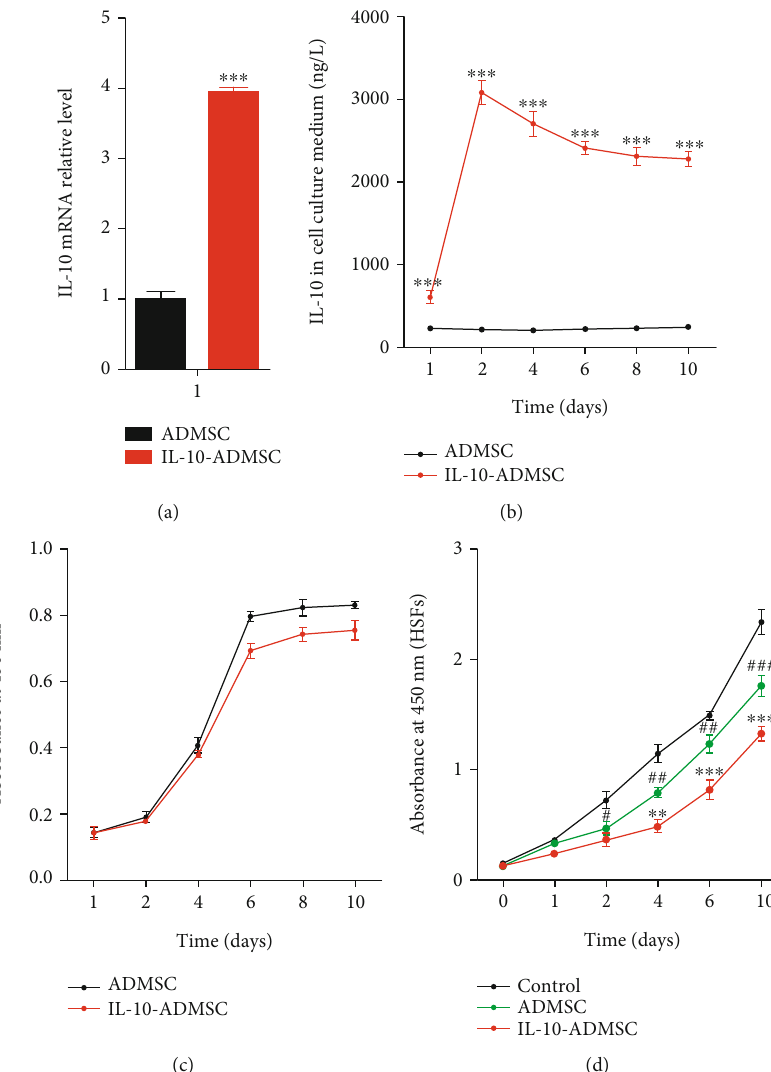
Figure 2: IL-10-modi fi ed ADMSC highly expresses IL-10 and inhibits the proliferation of HSFs. (a) 72 hours after lentivirus infection, we detected the expression of IL-10 mRNA in ADMSC; (b) 72 hours after lentivirus infection, we detected the expression of IL-10 protein in the medium of ADMSC; (c) IL-10 modi fi cation reduces the proliferation of ADMSC using CCK8 assay kit; (d) IL-10-modi fi ed ADMSC (IL-10- ADMSC) reduced the proliferation of hypertrophic scar fi broblasts (HSFs) in a cocultivation system of ADMSC and HSFs. Data was expressed as ( SD ± mean ), and each analysis was repeated at least 3 times independently; P value was calculated by Student ’ s t test or one-way ANOVA; ∗ was P < 0 : 05 , ∗∗ was P < 0 : 01 , and ∗∗∗ was P < 0 : 001 vs. ADMSC group; ### was P < 0 : 001 vs. control